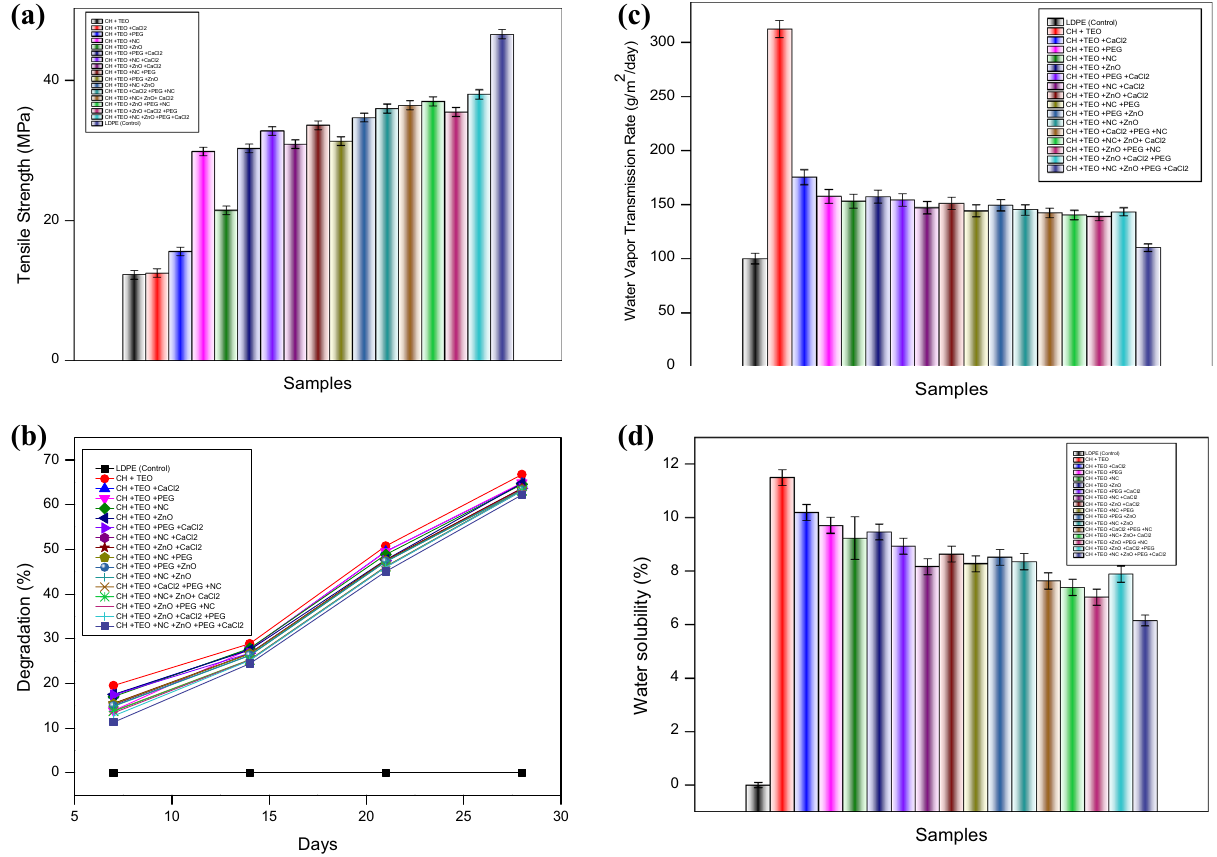
Figure 1. ( a ) Tensile strength of control and chitosan-based biodegradable films. ( b) Biodegradability of control and chitosan-based films. ( c) Water vapour transmission rate of different chitosan-based films. ( d) Water solubility of different chitosan-based